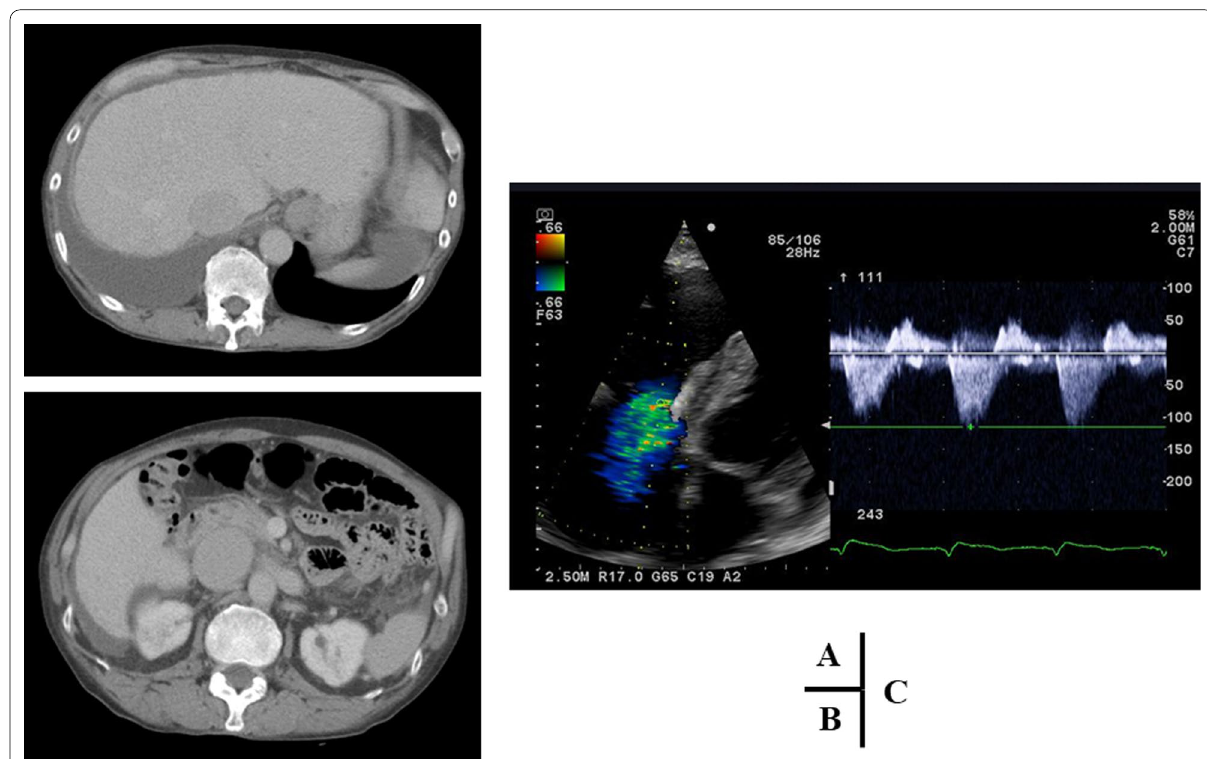
Fig. 2 Computed tomography revealed the presence of congestive liver and inferior vena cava dilatation ( A , B ). Echocardiography showed prominent enlargement of the right atrium and right ventricle, and severe TVR ( C )